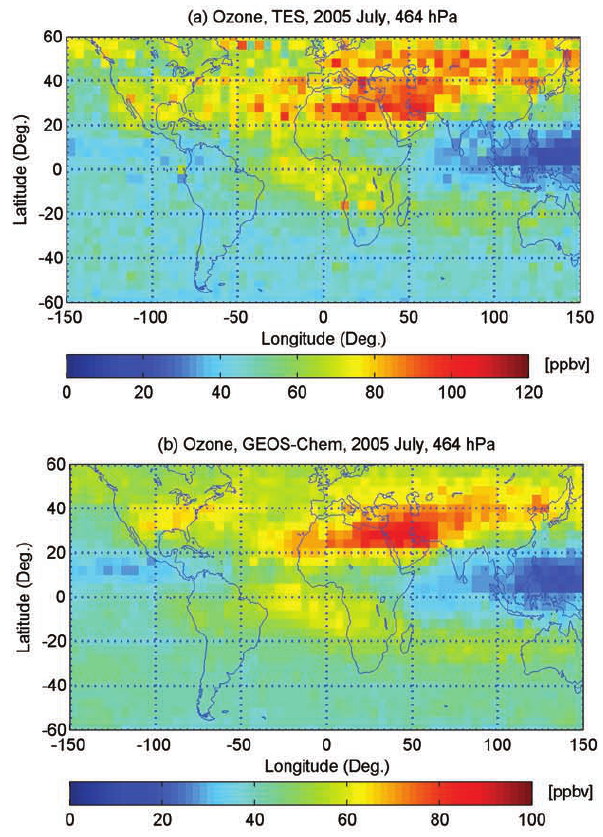
Fig. 48. Monthly mean ozone mixing ratio in July 2005 at 464hPa from (a) the TES satellite instrument, and (b) GEOS-Chem model simulation output, smoothed with the local TES averaging kernels; note the difference in scales (from Liu et al., 2009, copyright 2009 by the American Geophysical Union, reproduced with